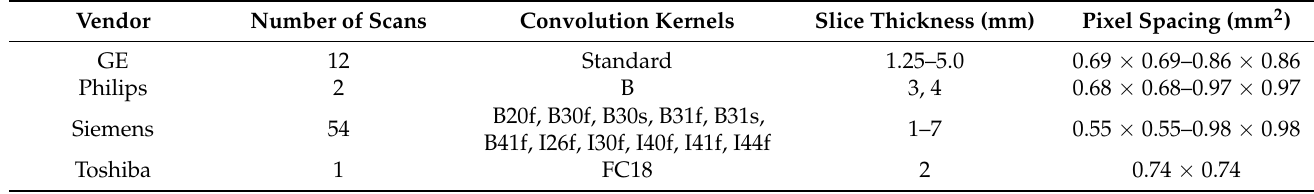
Table 1. Imaging hardware and parameters of the data